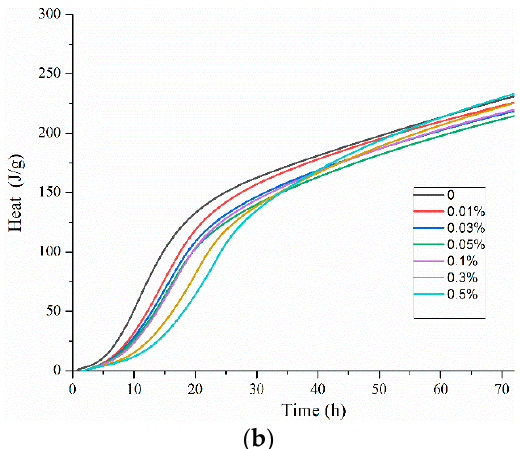
Figure 8. Isothermal calorimetry curves of plain cement paste and pastes admixed with 0–0.50% HPMC after 24 h of hydration: ( a ) incremental curves; ( b ) cumulative curves.